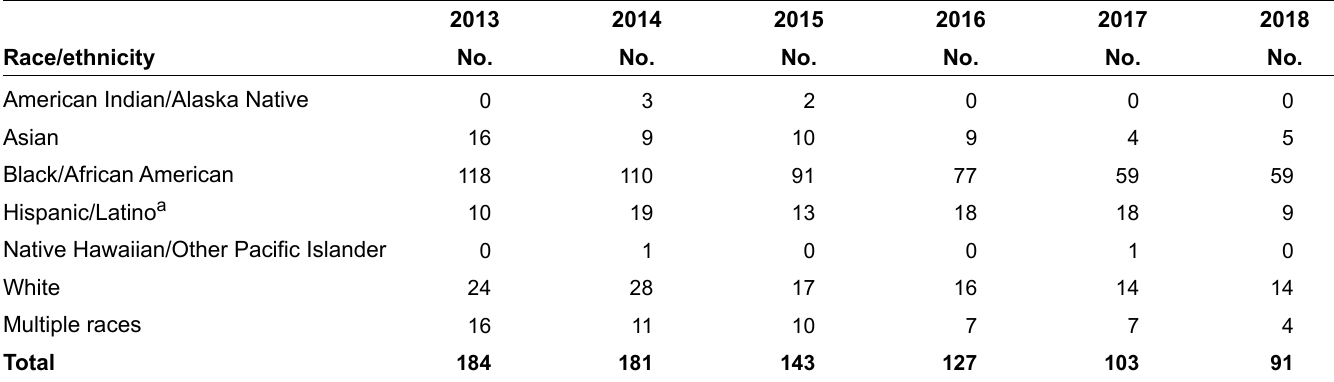
Table 13b. Diagnoses of HIV infection among children aged <13 years, by race/ethnicity, 2013–2018—United States and 6 dependent